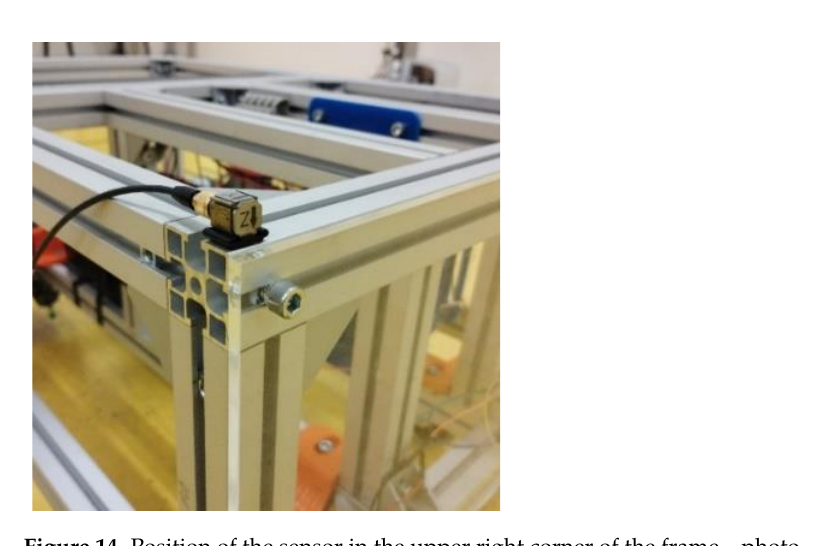
Figure 13. Location of the sensors on the robotic vehicle.